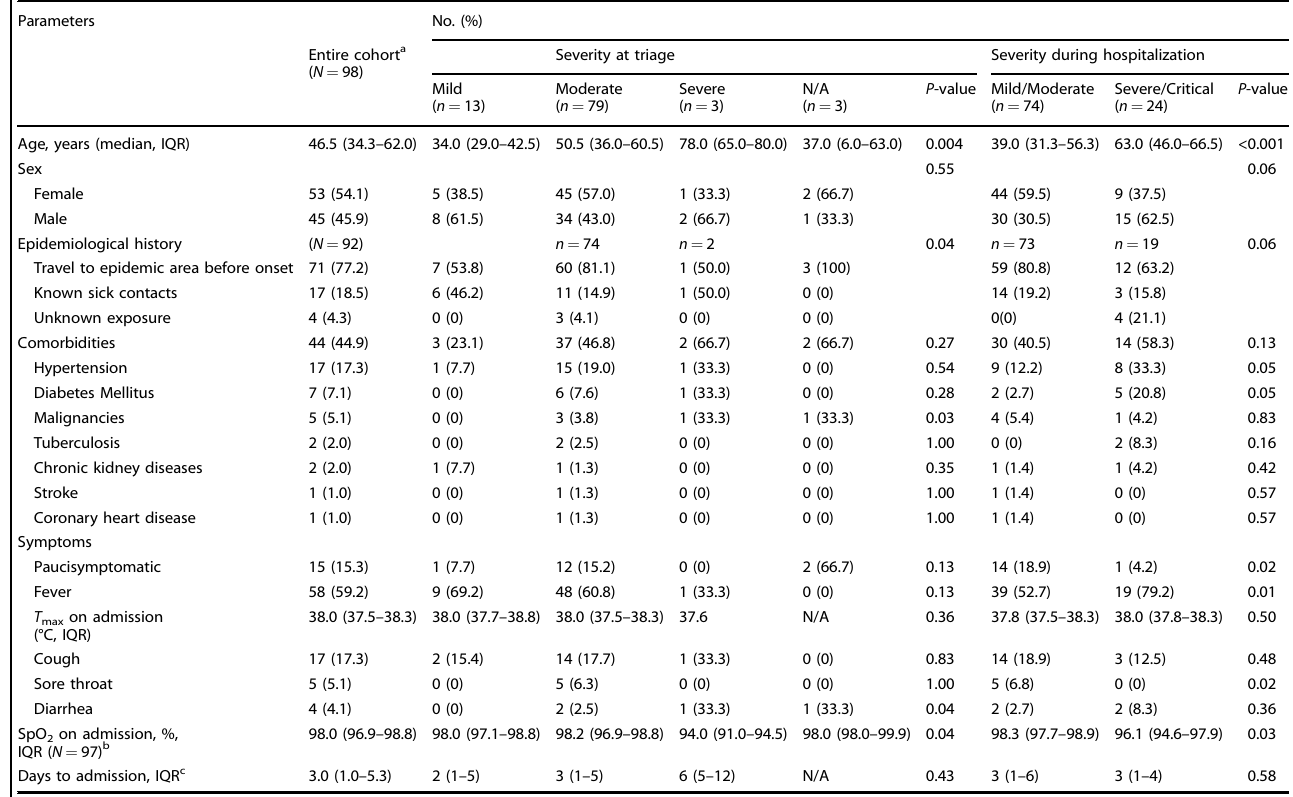
Table 1. Baseline characteristics of patients with COVID-19 on admission by severity at triage and severity during hospitalization.